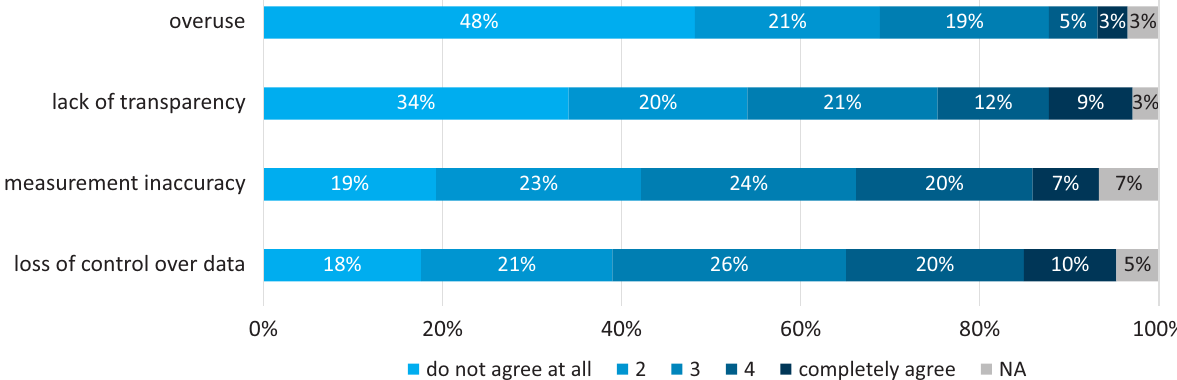
Figure 2. Distribution of indicators of risk awareness.